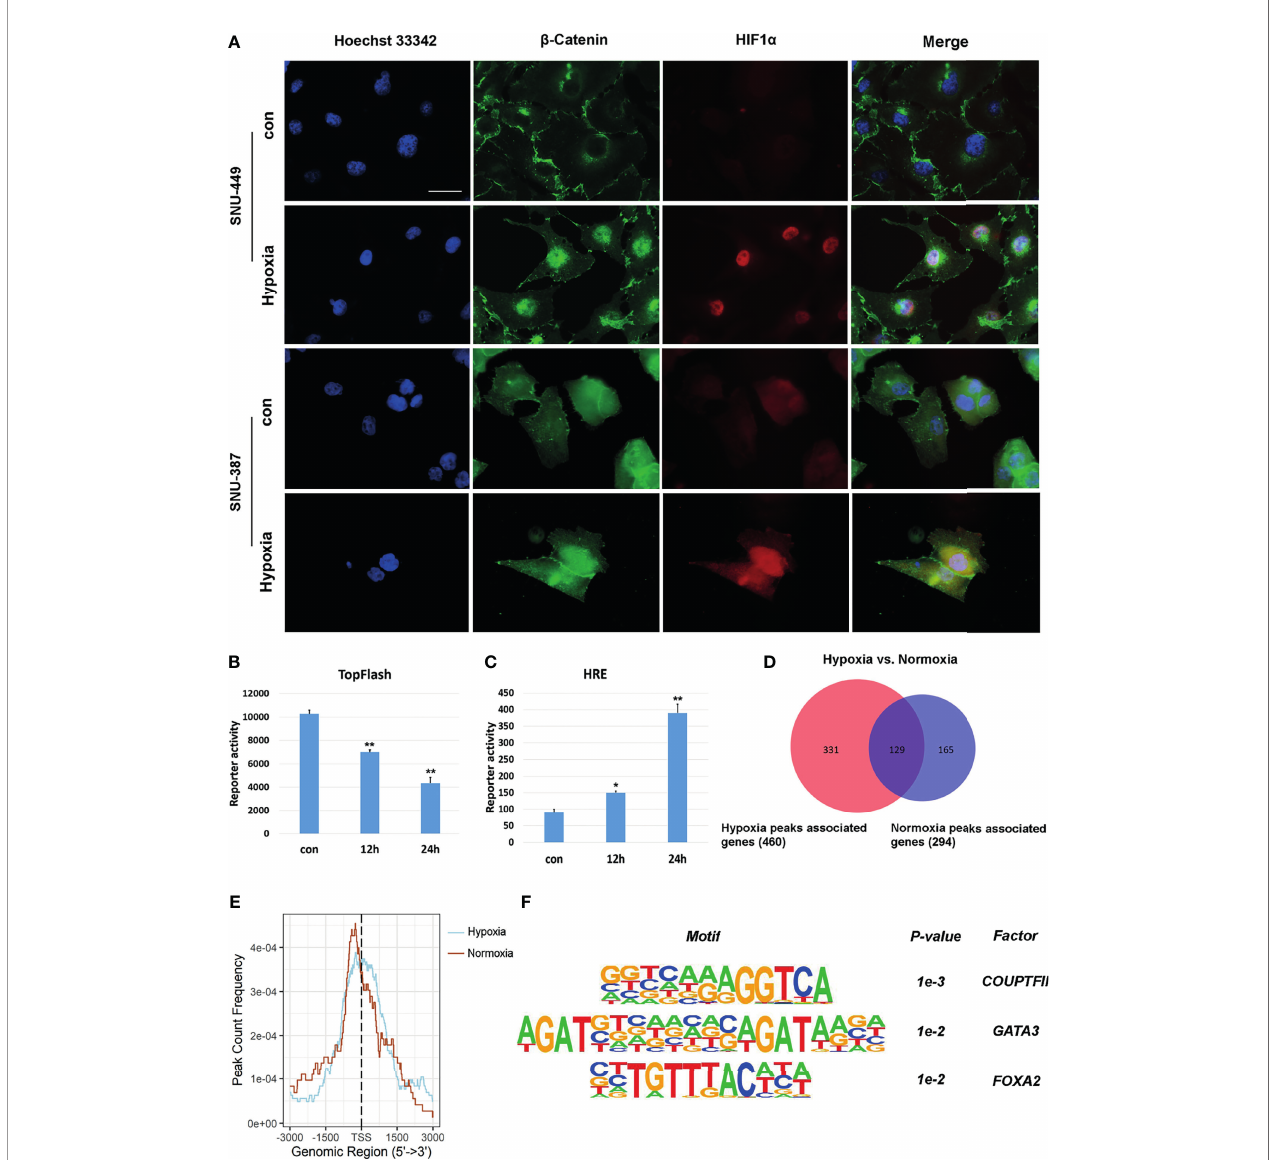
FIGURE 3 | Hypoxia affected the transcriptional activation of b -Catenin signaling on target genes. (A) Immuno fl uorescence staining for b -Catenin in SNU-449 and SNU-387cells under normoxic or hypoxic conditions. Scale ba r= 60 m m. (B, C) TOP fl ash or HRE-promoter luciferase plasmid were transfected into SNU-387 cells (means ± SD, n = 3, * P < 0.05, ** P < 0.01 versus the control group). (D) Venn diagram showing overlap between hypoxia group (red) and normoxia group (blue). (E) Analysis of hypoxia group and normoxia group ChIP peak signals. (F) Nucleotide binding motifs of b -Catenin under hypoxic